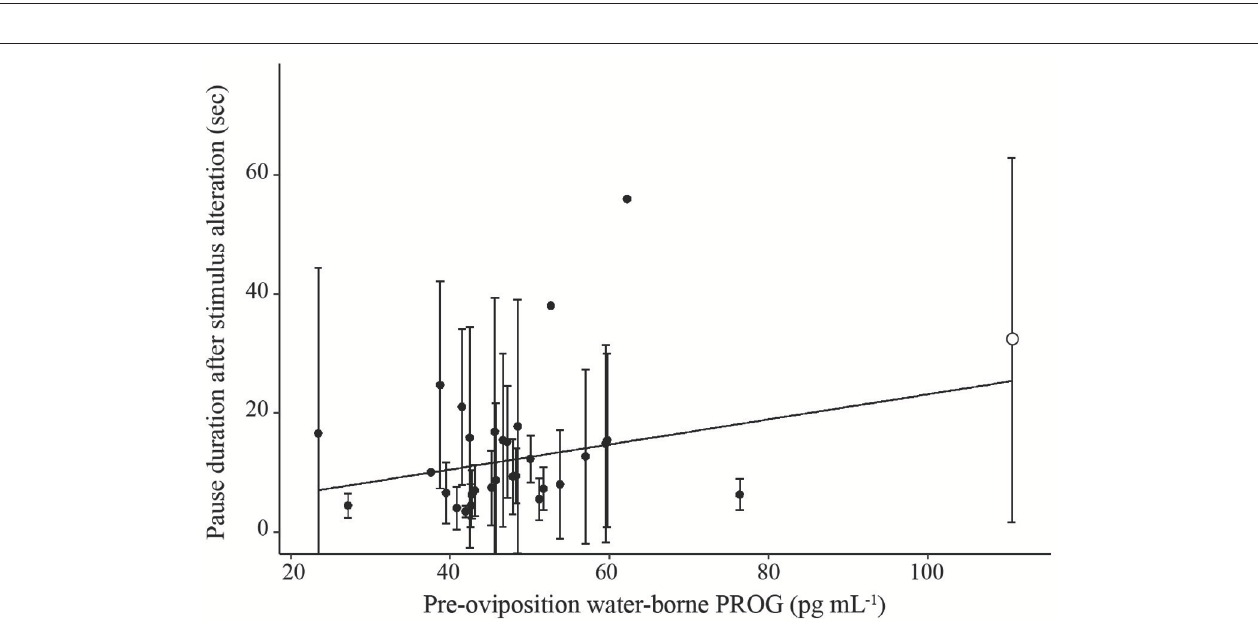
FIGURE 5 | Scatterplot illustrating the relationship between pre-oviposition water-borne progesterone and mean pause duration. Solid line represents a significant relationship ( p < 0.05). Error bars represent standard deviations. The single filled circle in the upper right had a significant effect on the regression.